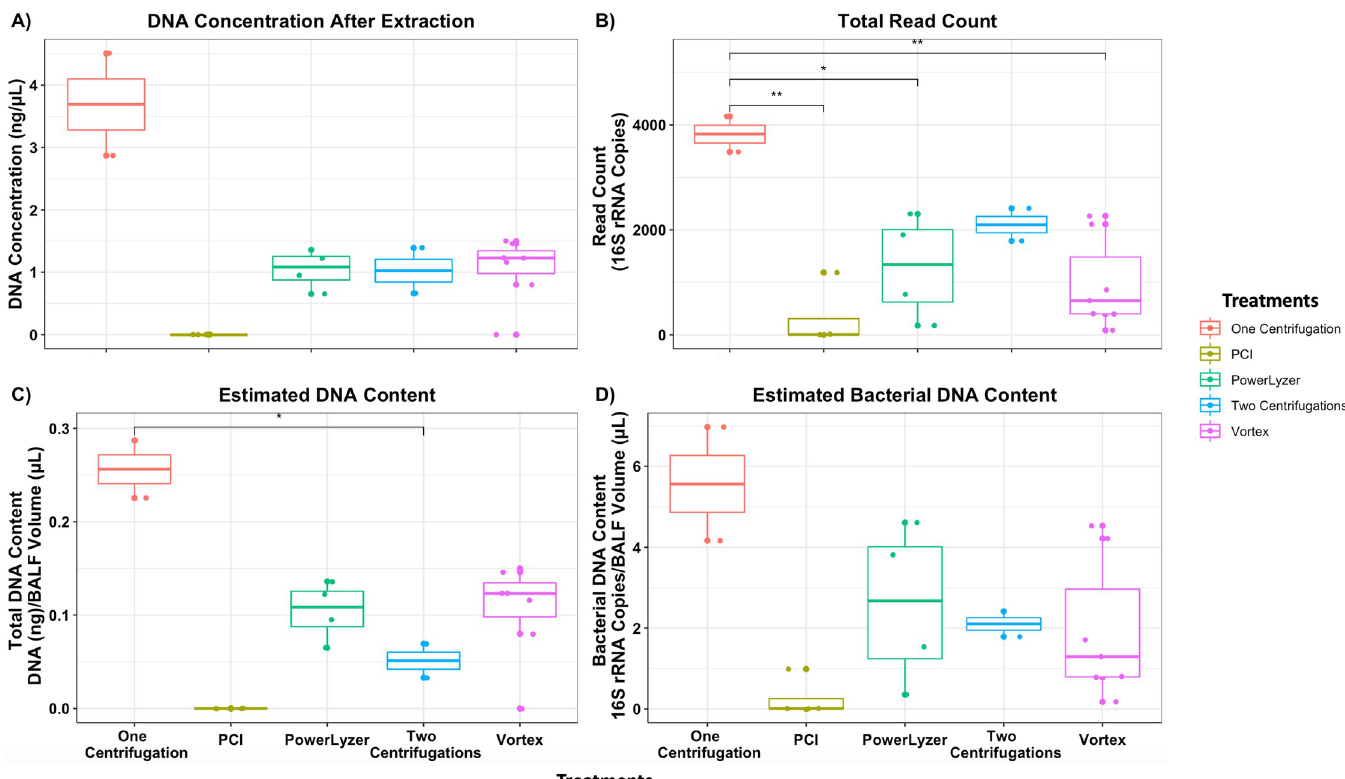
Fig 2. DNA content and estimated biomass of BALF samples. A) DNA concentration (ng/ μ L) of BALF samples, B) total read count is estimated based on the 16S rRNA gene copy number after quality filtering of the data, C) estimated DNA content dividing total DNA extracted by volume of the sample processed, and D) estimated bacterial DNA content dividing read count by volume of the sample processed. Significance (p-value) between groups is indicated by stars ( � < 0.05 and �� < 0.01). Based on overall data, most effective pre-treatment method for BALF samples was a one Method centrifugation followed by mechanical cell lysis. Two Method centrifugation was less